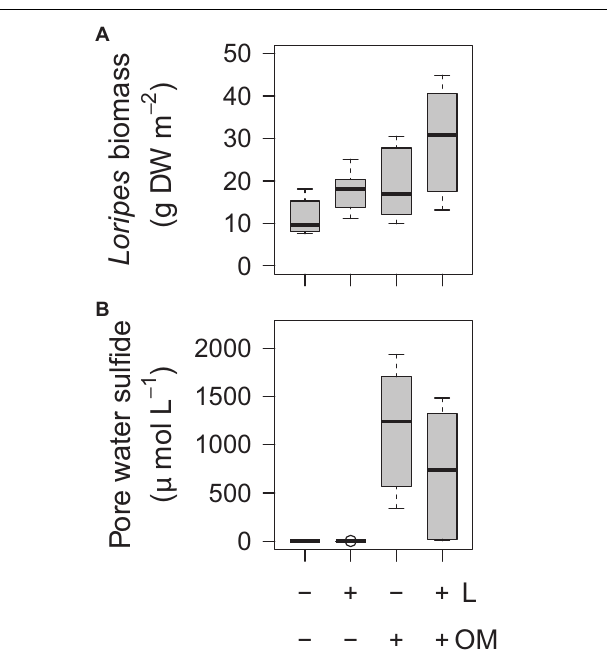
FIGURE 6 | Boxplots of (A) Loripes orbiculatus biomass and (B) pore water sulfide concentrations per treatment (n = 6 per treatment) after 50 and 49 days, respectively. L, addition of L. orbiculatus clams; OM, addition of organic matter; DW, dry weight. Midline in box; median; box: 25th and 75th percentiles; whiskers: 1.5 × interquartile range; circles: